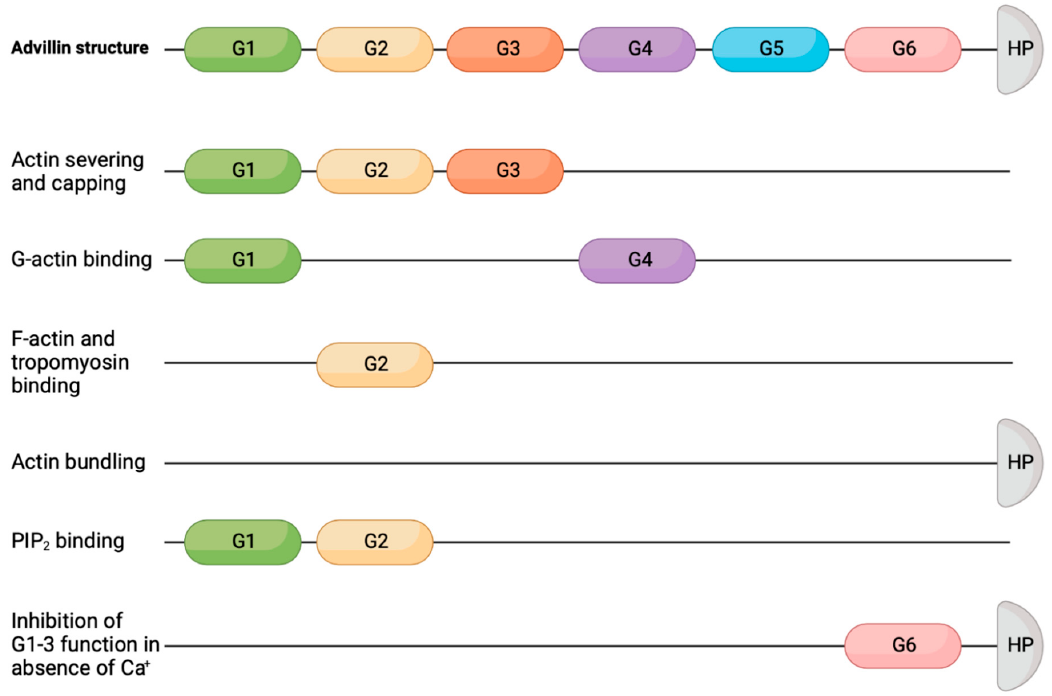
Figure 2. Advillin protein structure and domain functions.